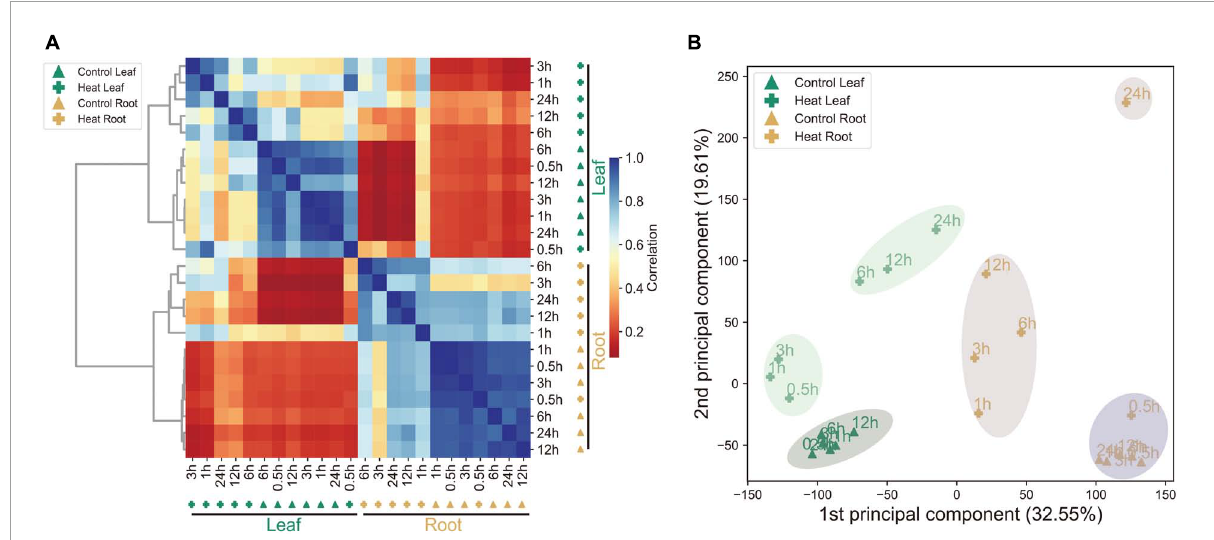
FIGURE1 Summary of the transcriptomics data. (A) Hierarchical clustering analysis of 35,336 genes from 24 samples. Color scale represents Pearson’s correlation coefficient (0–1). (B) PCA of the leaf and root transcriptomes from the control and heat-treated